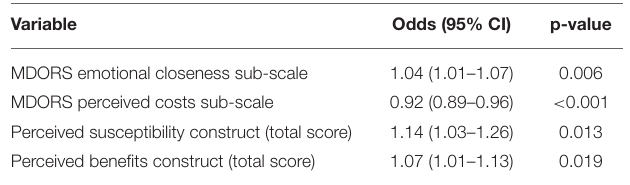
TABLE 7 | Multiple logistic regression model of seeking veterinary healthcare during the COVID-19 pandemic.